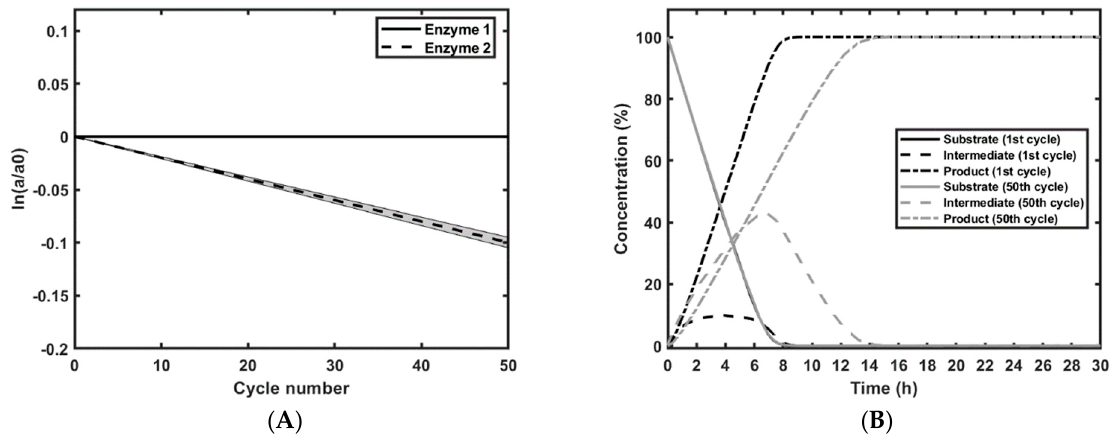
Figure 5. Enzyme 2 deactivates, while enzyme 1 remains fully active. ( A ) The deactivation is assumed to be first-order decay, with a deactivation constant of 0.002 h − 1 . The shaded area indicates an error of ±5%. ( B ) Simulated time course of the concentration profile. The black line shows the initial reaction cycles, and the grey lines illustrate the time course of the 50th reaction cycle in the presence of deactivation, with a deactivation constant at 0.002 h − 1 . Kinetic parameters and initial enzyme concentrations are listed in Table 1.